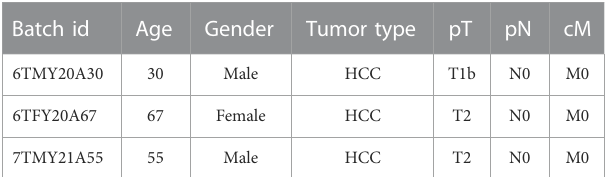
TABLE 1 Donor information on the liver tissues. Batch